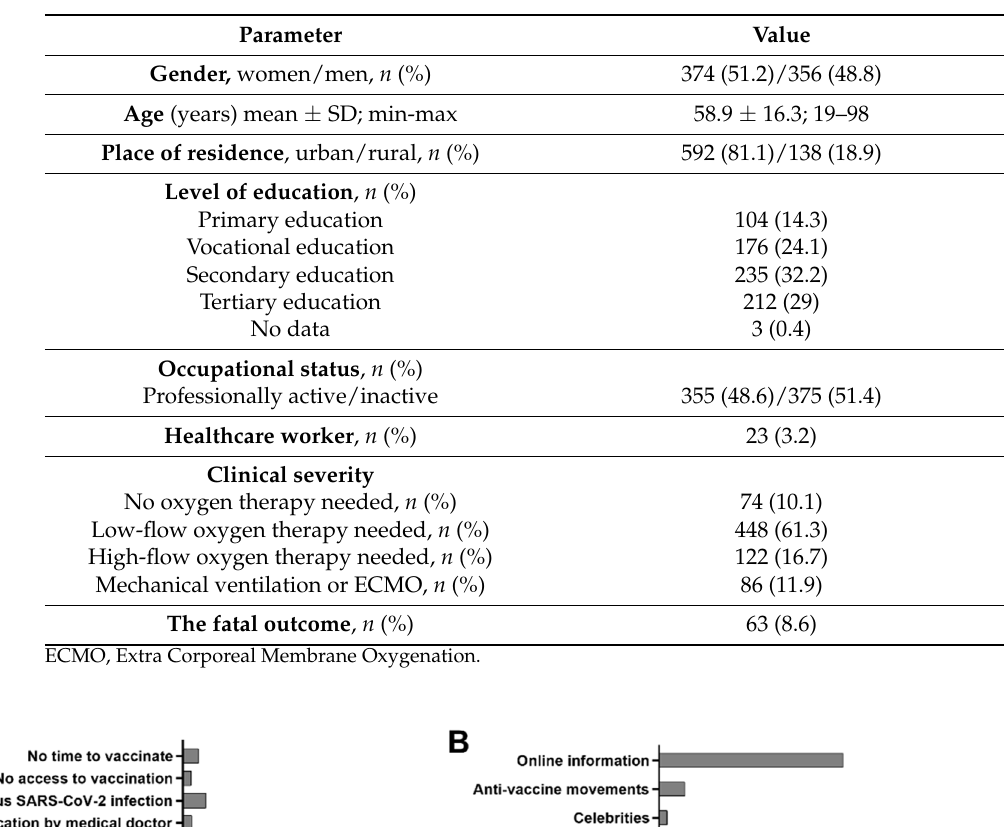
Table 1. Demographic characteristics of unvaccinated Polish patients hospitalized due to COVID-19 included in the study ( n = 730).